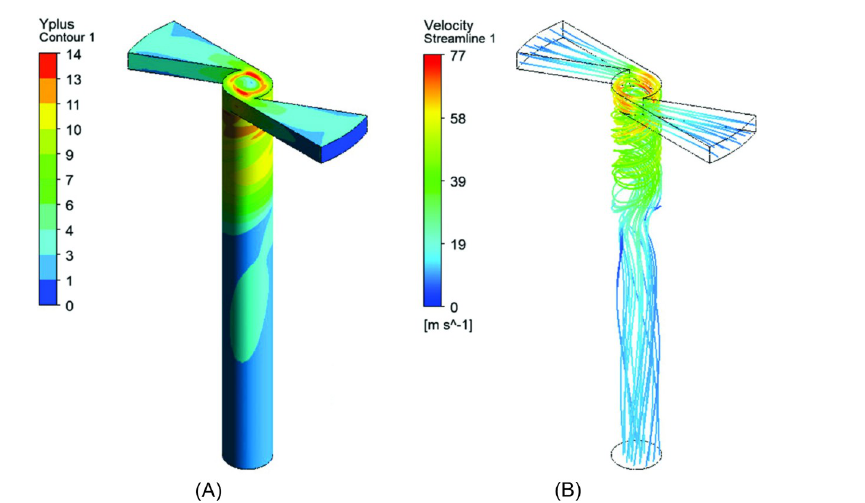
Fig 11. Contours of the nebulizer nozzle. (A) Yplus; (B) Streamline.